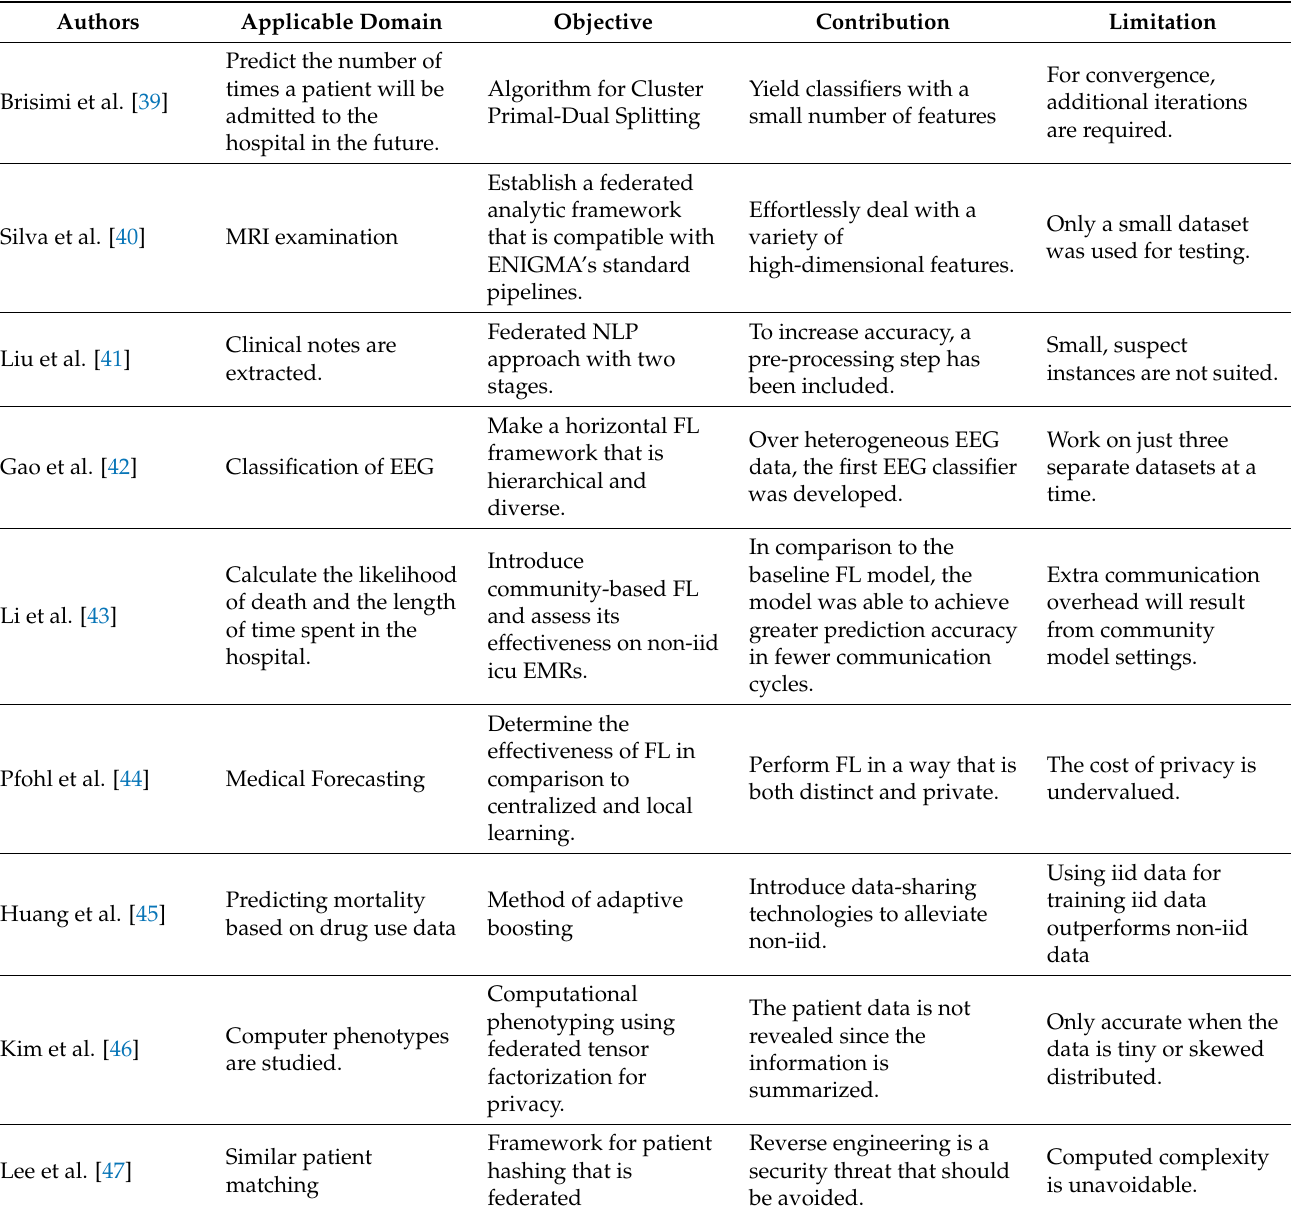
Table 9. Summary of FL application in